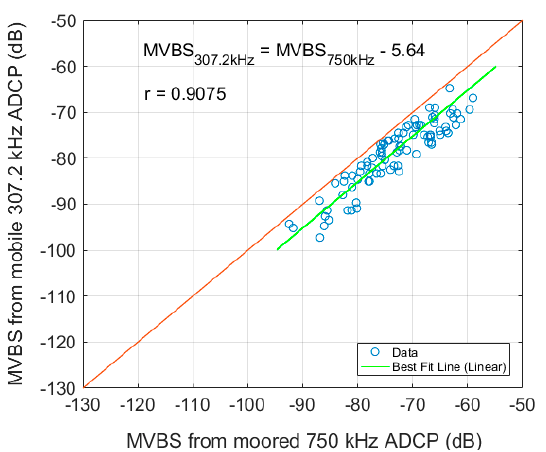
Figure 7. Relationship of MVBSs inside the SSL (11.5 – 16 m) determined from the selected ensemble from the four-beam averaged in two ADCPs. from the four-beam averaged in two